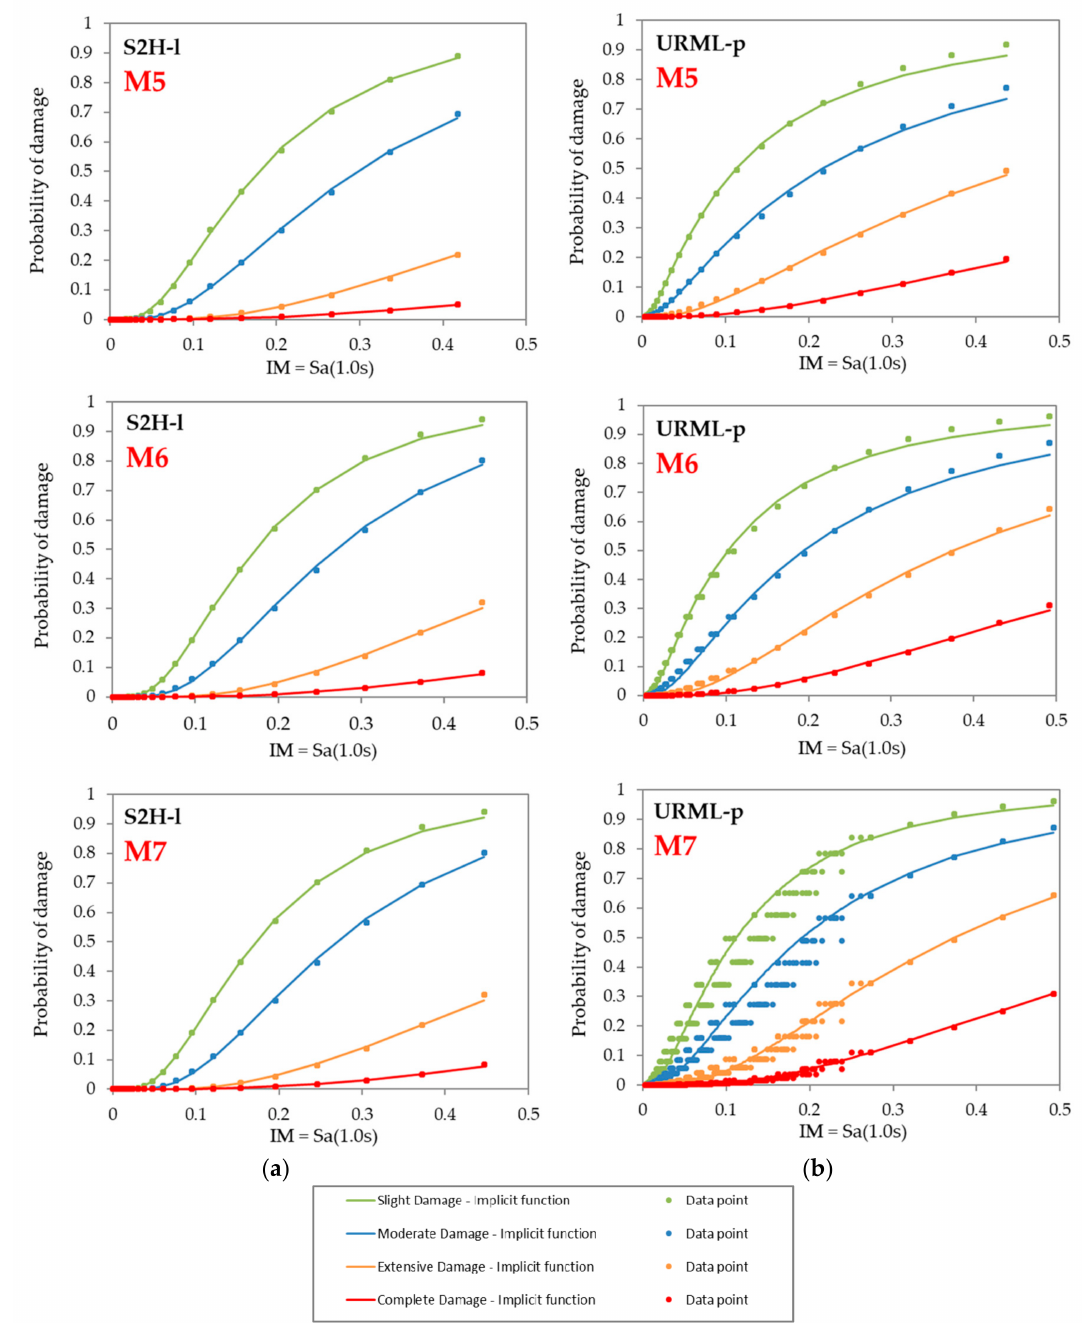
Figure 4. Implicit fragility functions for magnitudes M5, M6 and M7: ( a ) Steel braced frame (S2H-l); ( b ) Unreinforced masonry (URML-p). Continuous lines are relative to the building classes given